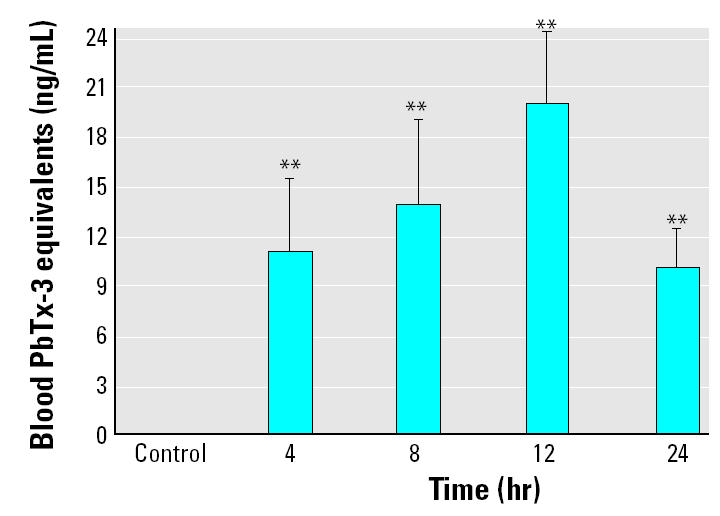
Blood brevetoxin levels after high-dose K. brevis exposure (3.49 ng/mL). Blood was collected from one fish in each of the four exposure tanks at each time point (0, 4, 8, 12, and 24 hr). Water toxicity remained unchanged (3.49 ± 0.20 ng/mL) throughout the course of the exposure, but blood brevetoxin levels increased to 19.23 ± 1.72 ng/mL at 12 hr and then declined to 9.63 ± 1.64 ng/mL after 24 hr exposure. The results shown are mean ± SE for four animals at each time point from a single experiment.
**p < 0.01 compared with control.